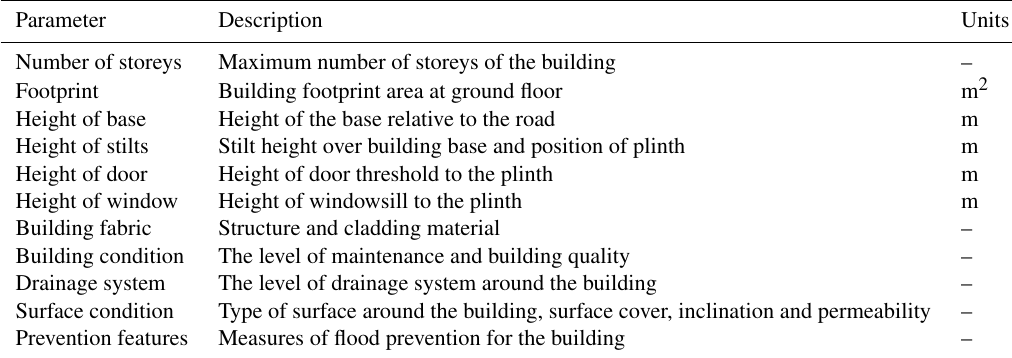
Figure 5. Example of traditional buildings in Kampung Baru and indication of the vulnerability index parameters. Table 2. Flood vulnerability index parameters for PARNASSUS